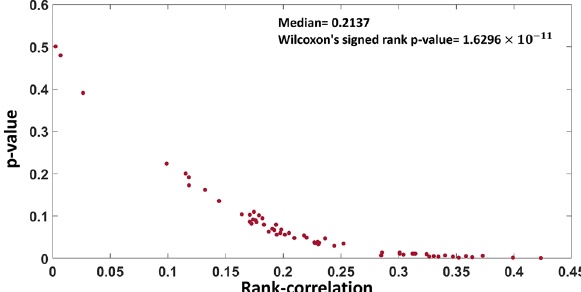
Figure 7. Validation of predicted cell-line specific responses of drugs. Distribution of measured Spearman rank-correlation between predicted FCG of drugs using GSMM and their log GI50 values for the 60 cell-lines. The p -values were measured using permutation